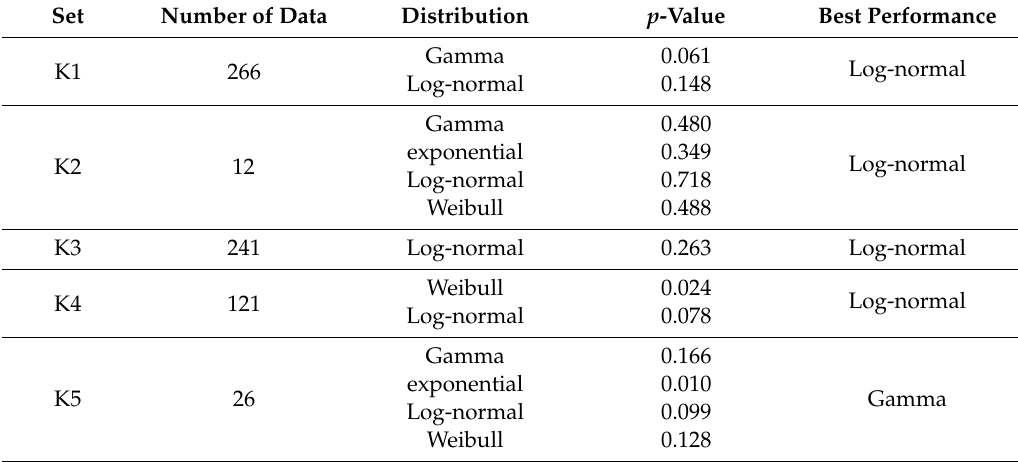
Table 5. The goodness of fit evaluated through the Kolmogorov–Smirnov (K–S) test (significance level α = 0.01). Only accepted distributions are